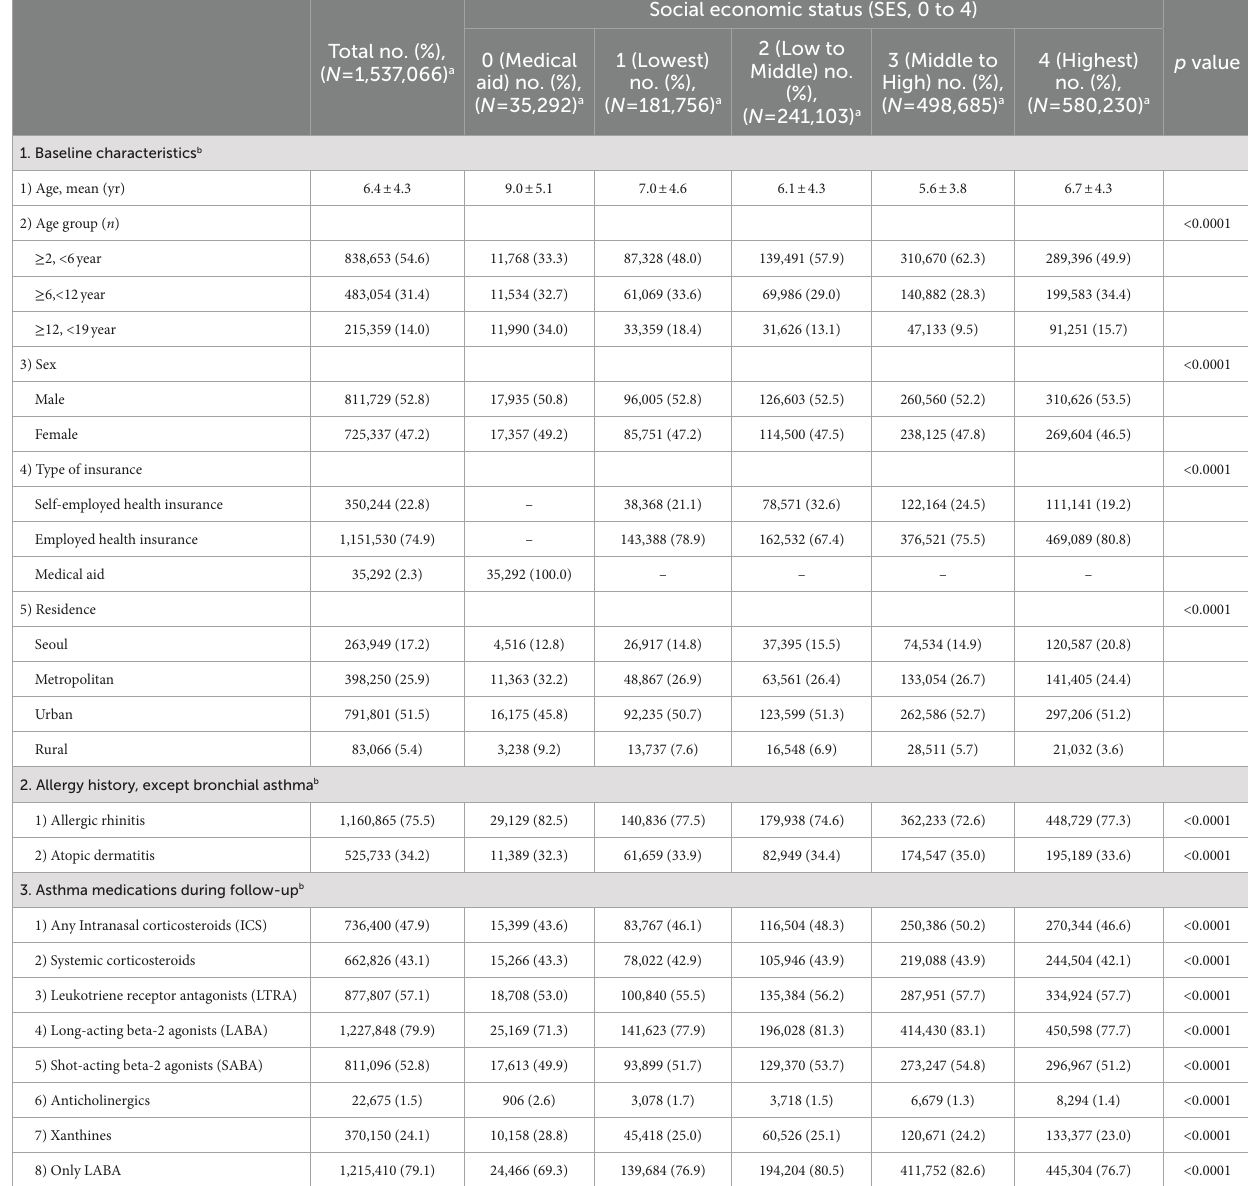
Social economic status (SES, 0 to 4)